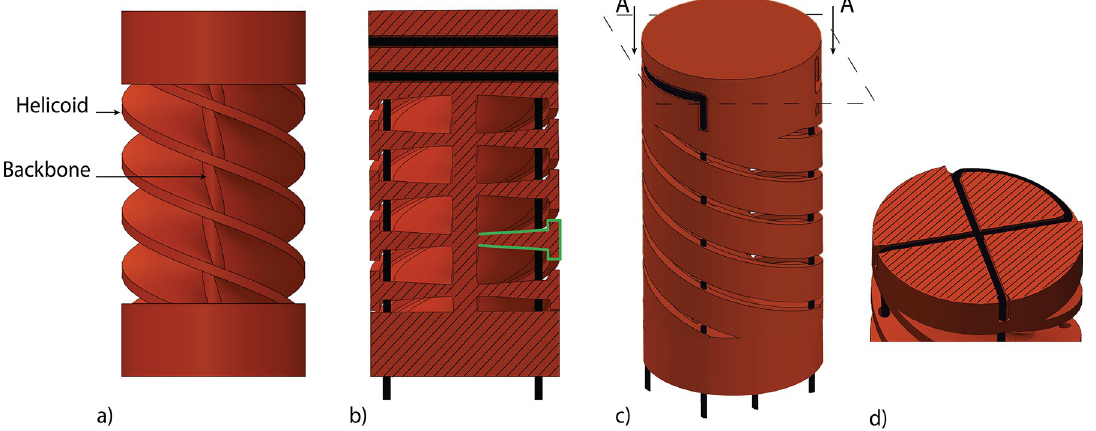
Fig 5. Steerable segment with parallel cables. A) Four helicoids concentrically placed around the central backbone. b) Cross-Section of the steerable segments with the T-shape of the helicoids highlighted in green and cables in black. c) 3D model of the steerable segment with d) cross-section A-A showing the looped cables in the fixation point. Adapted from [24].